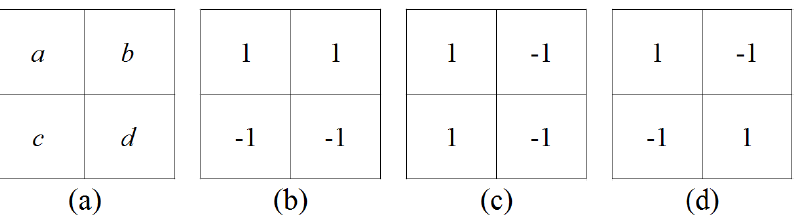
Figure 8. Haar filters for different directions. ( a ) Example of a 2 × 2 square pixel block to be filtered by Haar filters. ( b ) Haar filter for horizontal direction. ( c ) Haar filter for vertical direction. ( d ) Haar filter for diagonal